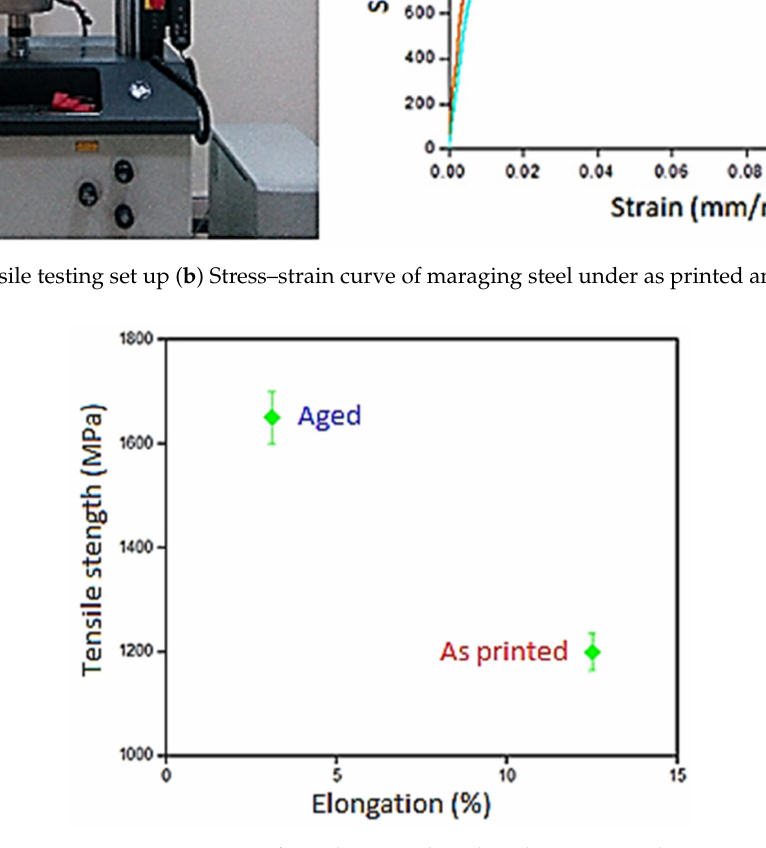
Figure 9. Variation of tensile strength and % elongation with aging treatment.